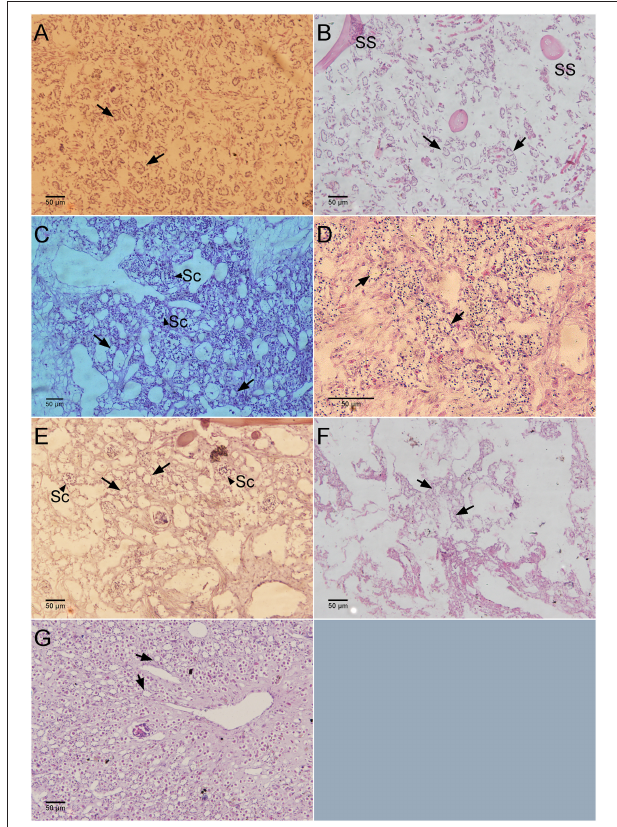
FIGURE 6 | Histological sections showing the number of chaonocyte chambers per view field. (A) Haliclona sp., (B) Calyspongia sp., (C) Amorphinopsis foetida, (D) Suberites carnosus, (E) Ircinia fusca, (F) Biemna fortis, (G) Cinachyrella cf. cavernosa. Black arrows point toward the choanocyte chambers. The black arrow head indicates the sperm cysts (Sc). SS, Spongin skeleton.